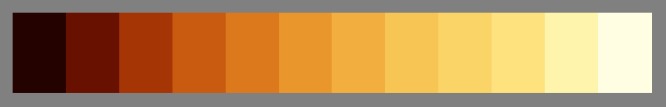
A well-tempered temperature scale of a dozen steps.